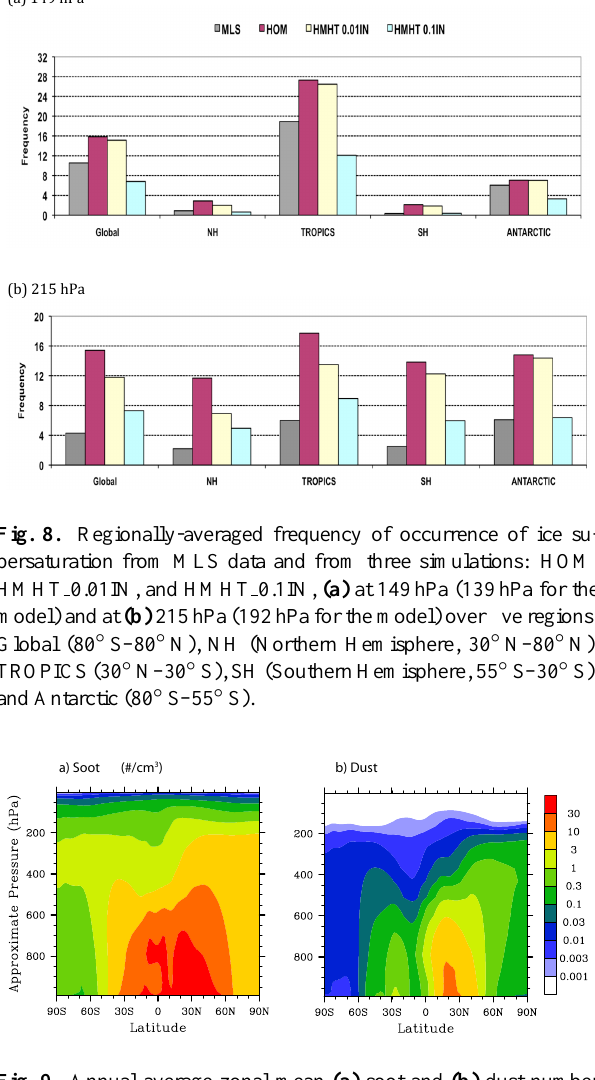
Figure 09 Fig. 9. Annual average zonal mean (a) soot and (b) dust number concentration (#/cm 3